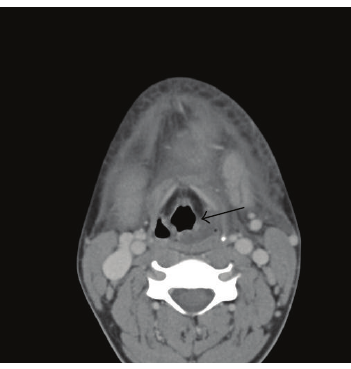
Figure 2: CT-scan demonstrating fluid collections in the left lateral pharyngeal space